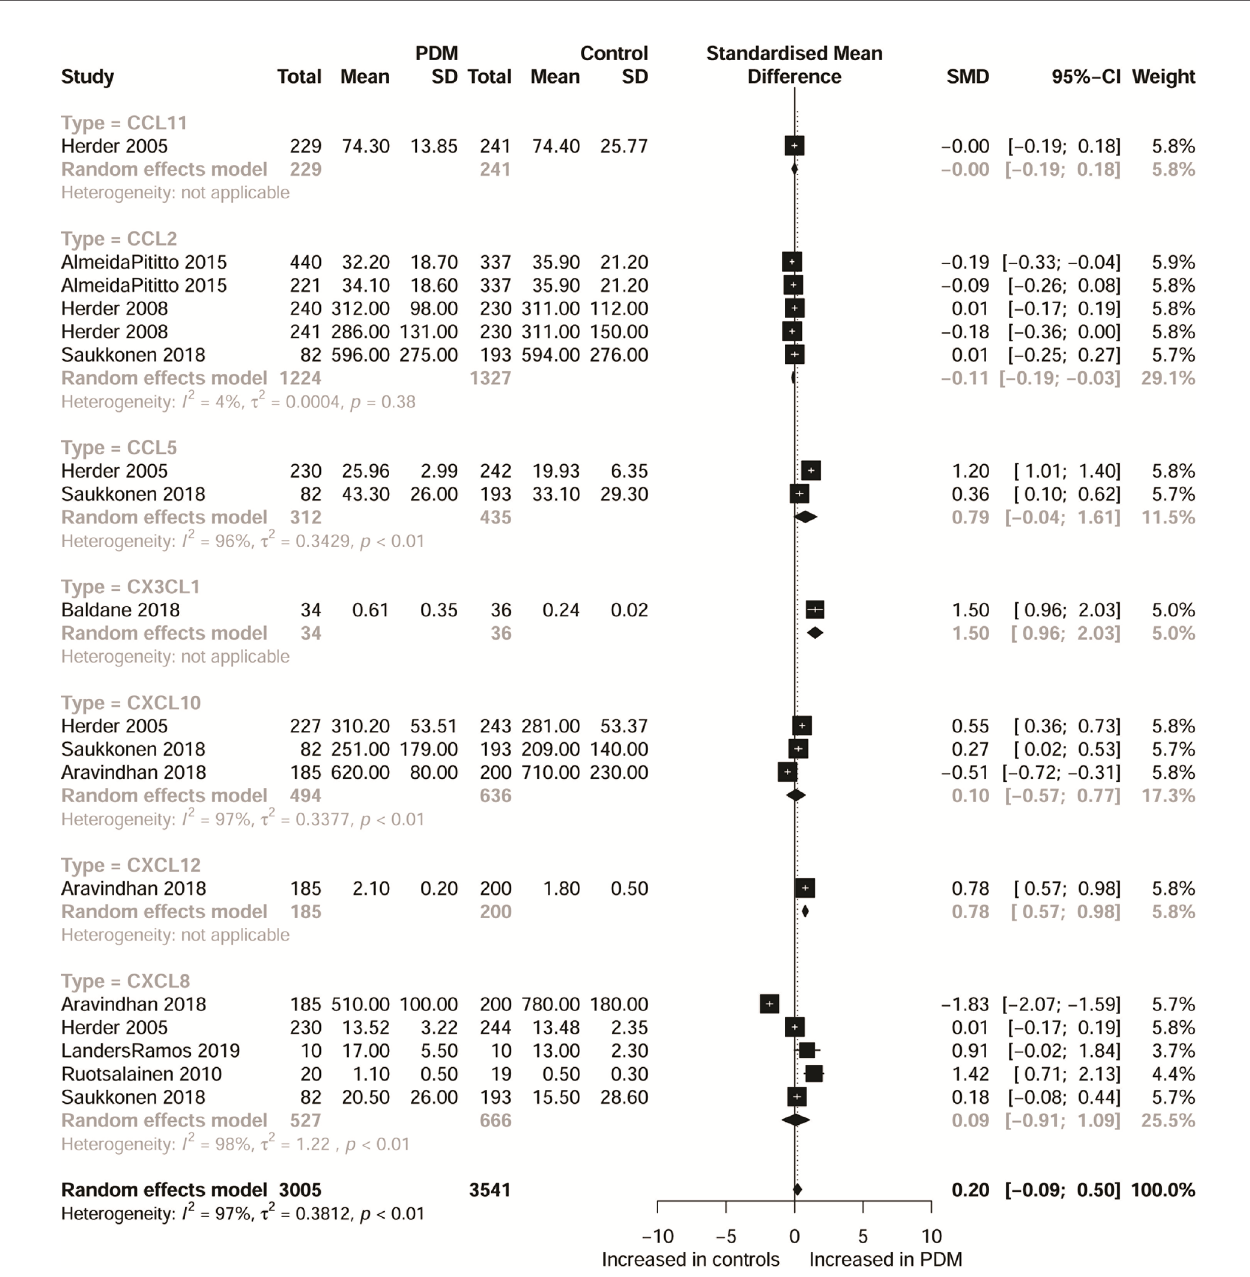
FIGURE 2 | Forest plot of chemokine between PDM patients and controls. Study effect sizes of chemokines differences between PDM and controls. Each data marker represents a study, and the size of the data marker is proportional to the total number of individuals in that study. The summary effect size for each chemokines is denoted by a diamond. PDM, prediabetes diabetes mellitus; SMD, standardized mean